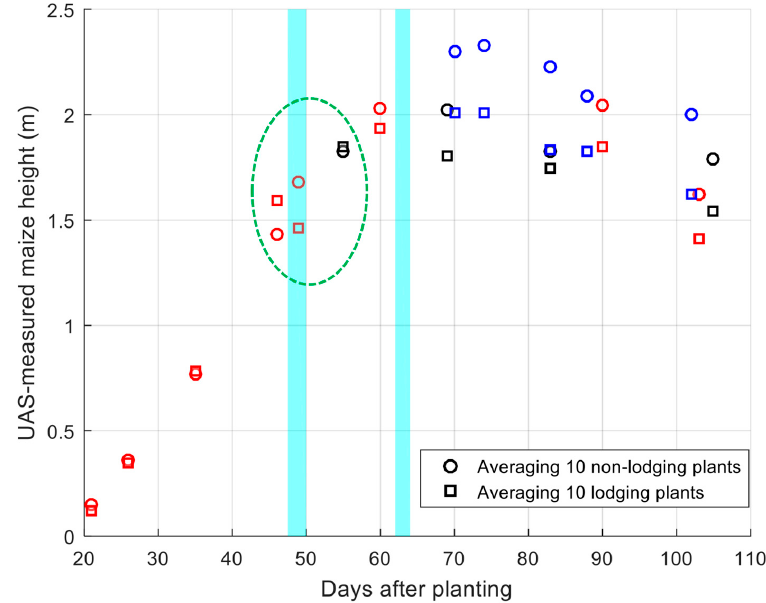
Figure 7. Height comparison by averaging ten exemplary non-lodging and lodging plots, respectively. Markers with red, blue, and black colors depict results from the DJI Phantom 4, 3DR Solo, and eBee platforms, respectively. Two cyan-colored windows represent main lodging events during the entire growing season. The dotted green oval highlights how the plant height changed before, during and after the first lodging event.